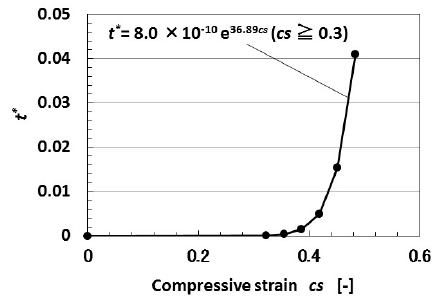
Figure 8. Theoretical results of dimensionless time constant to compression by tunneling theory.